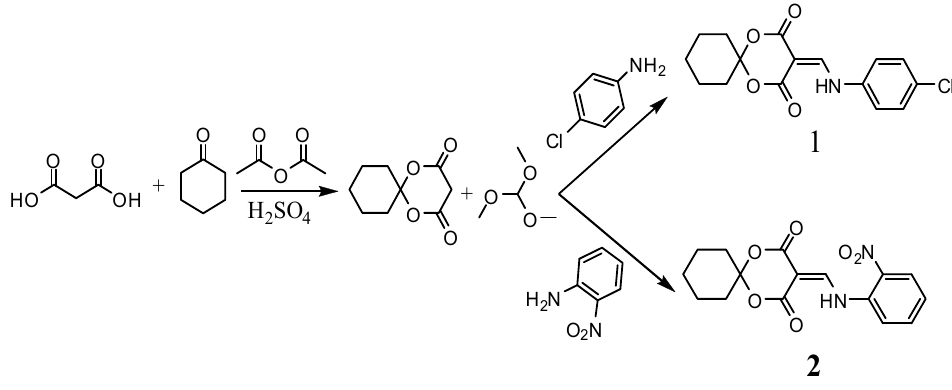
Scheme 1. Synthesis of two spiro compounds.